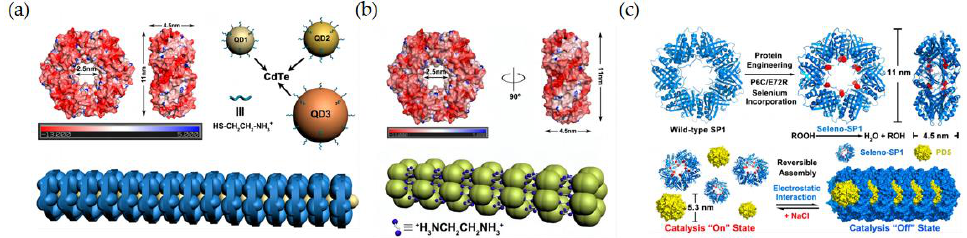
Figure 6. Selenium-containing enzyme mimics constructed based on assembly electrostatic interactions. ( a ) Quantum dots with SP1 protein. Reproduced with permission from L. Miao et al. [85]. ( b ) EDA with SP1 protein. Reproduced with permission from L. Miao et al. [86]. ( c ) PAMAM with SP1 protein. Reproduced with permission from T. Pan et al. [87].